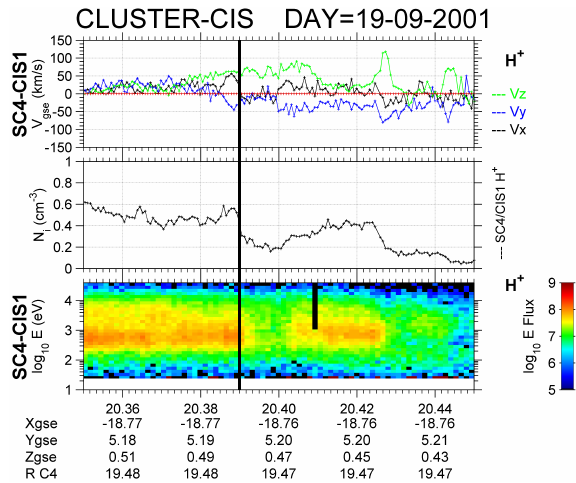
Fig. 14. H + ion velocity components, H + density and energy-time spectrogram, measured by CIS on s/c 4. The black arrow in the bot- tom panel marks the onset time as determined from ground-based magnetic field